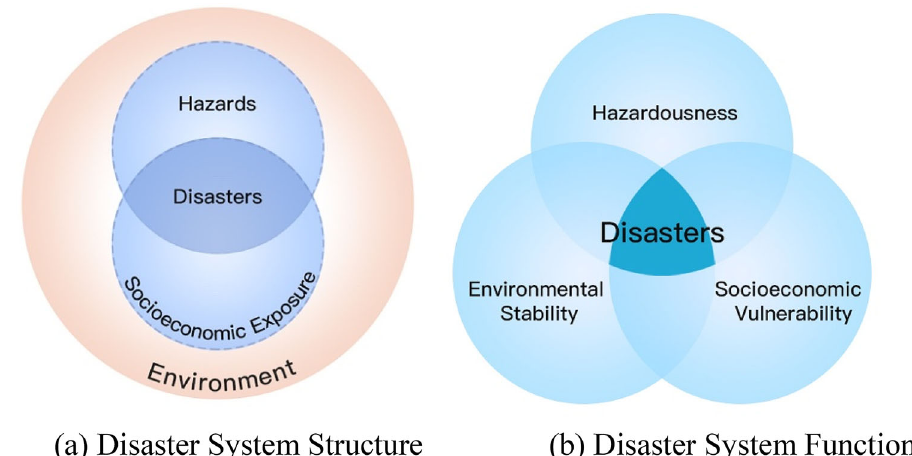
Fig. 2 A conceptual model of disaster system. Source Adapted from Shi (1991,